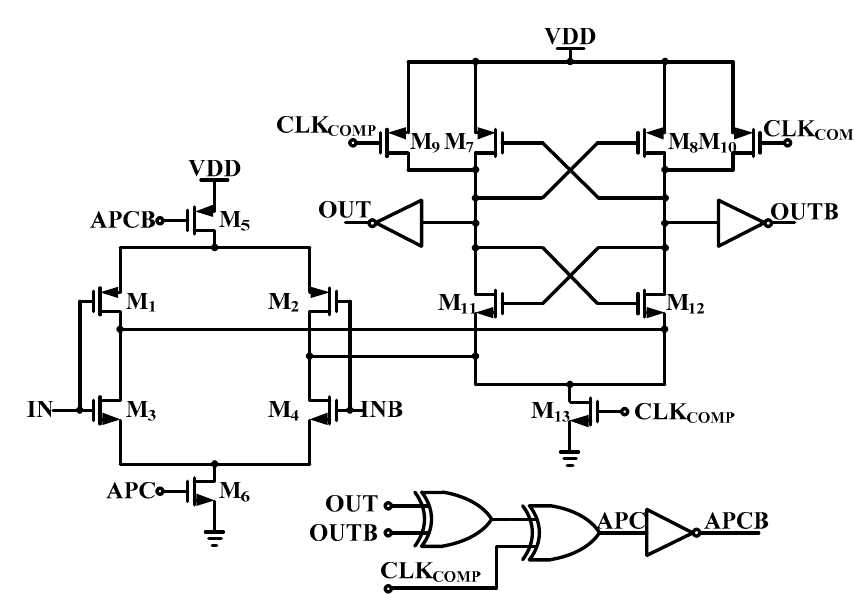
Figure 13. Schematic of the proposed dynamic latched comparator.